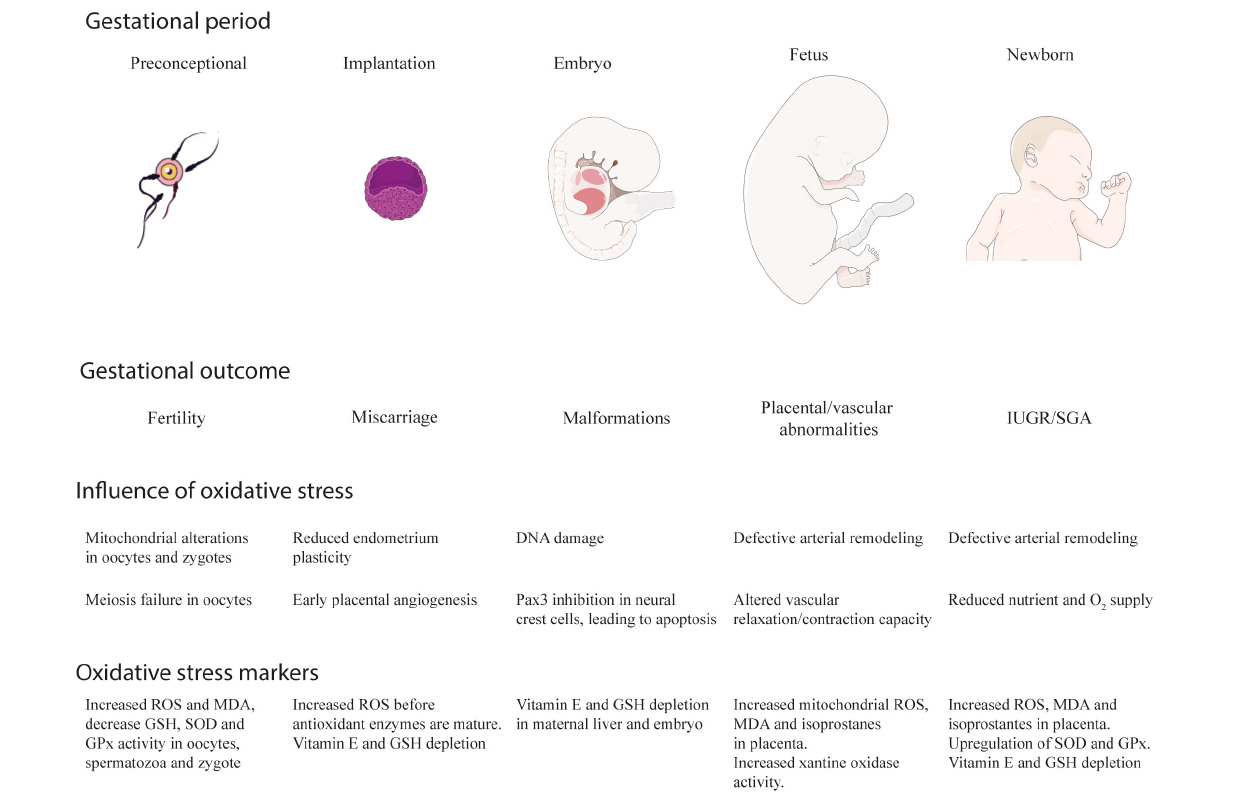
FIGURE 2 | Obesity, gestation and oxidative stress. Pregestational obesity increases the risk of suffering adverse outcomes prior (reduced fertility), during (spontaneous abortion, embryo malformations, preeclampsia, intrauterine growth retardation) and after gestation (small and large for gestational age deliveries) for both the mother and the fetus. Oxidative stress is a common feature in the etiology of obesity and can cause an accumulative effect with the oxidative stress that appears during gestation. The effects and the evidences of oxidative stress in obesity-complicated pregnancies are here summarized. IUGR, intrauterine growth retardation; SGA, small for gestational age; ROS, reactive oxygen species; MDA, malondialdehyde. Artwork was obtained from Servier Medical Art, licensed under a Creative Common Attribution 3.0 Generic License.